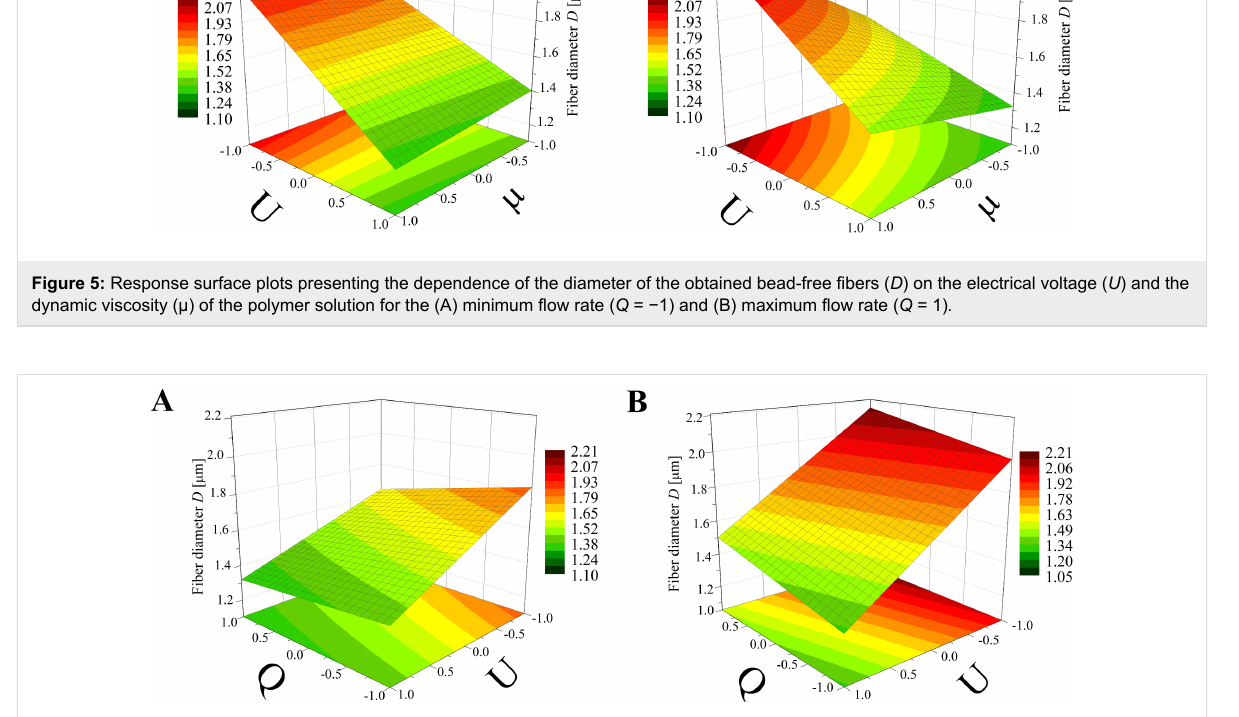
rate ( Q = − 1, Figure 5A), the electrical voltage should be varied in the range from U = 0 to U = 0.5 while the dynamic viscosity may be of any value. However, for the maximum flow rate ( Q = +1, Figure 5B), the voltage range variation depends on the viscosity value – for example, for μ = 1 the voltage should be between U = 0.5 and U = 0.75. The actual values of the parame- ters can be obtained on the basis of an appropriate interpreta-